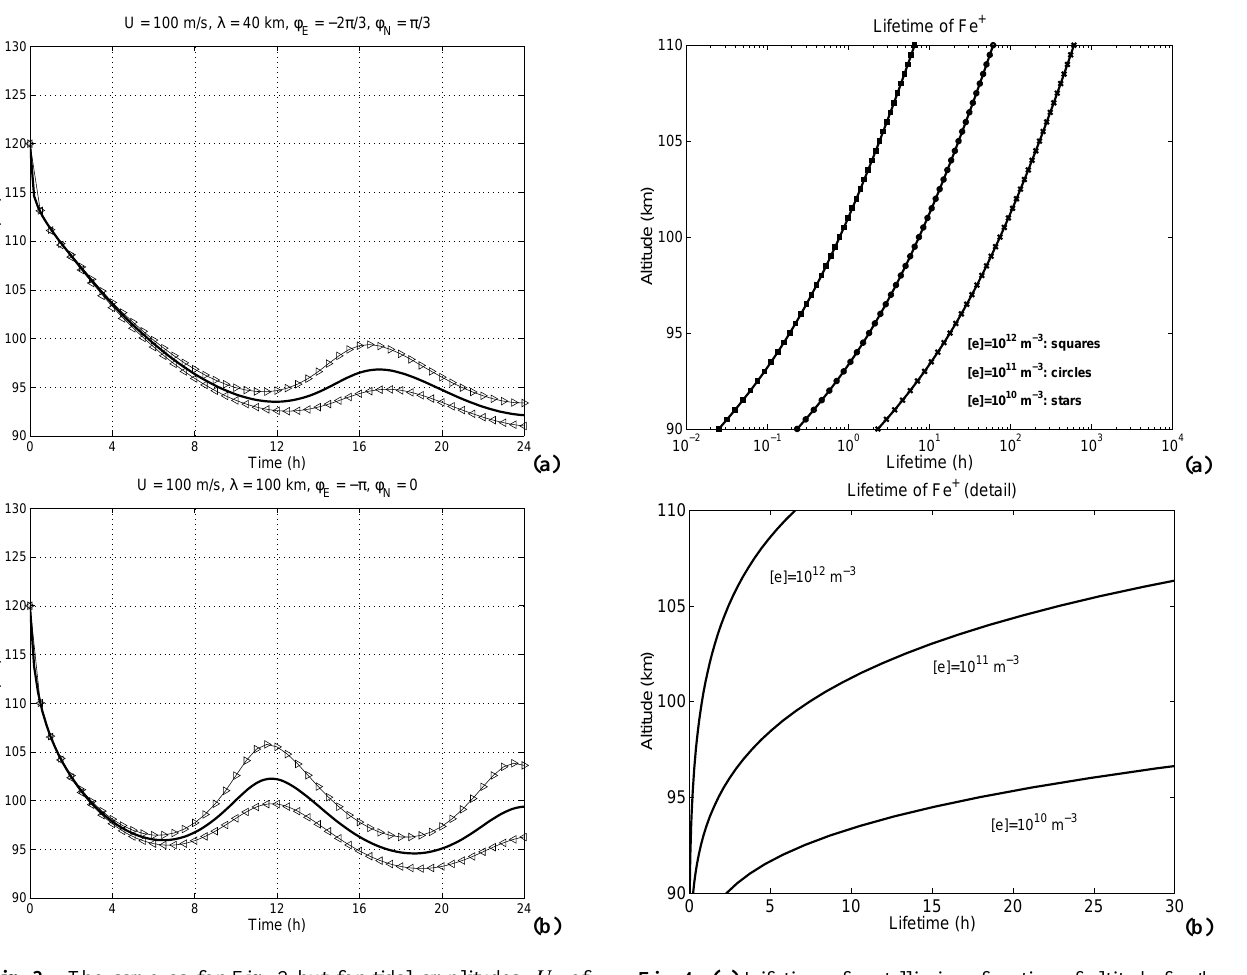
Fig. 4. (a) Lifetime of metallic ions function of altitude for three different electron densities. (b) Detail of plot (a), for lifetimes of